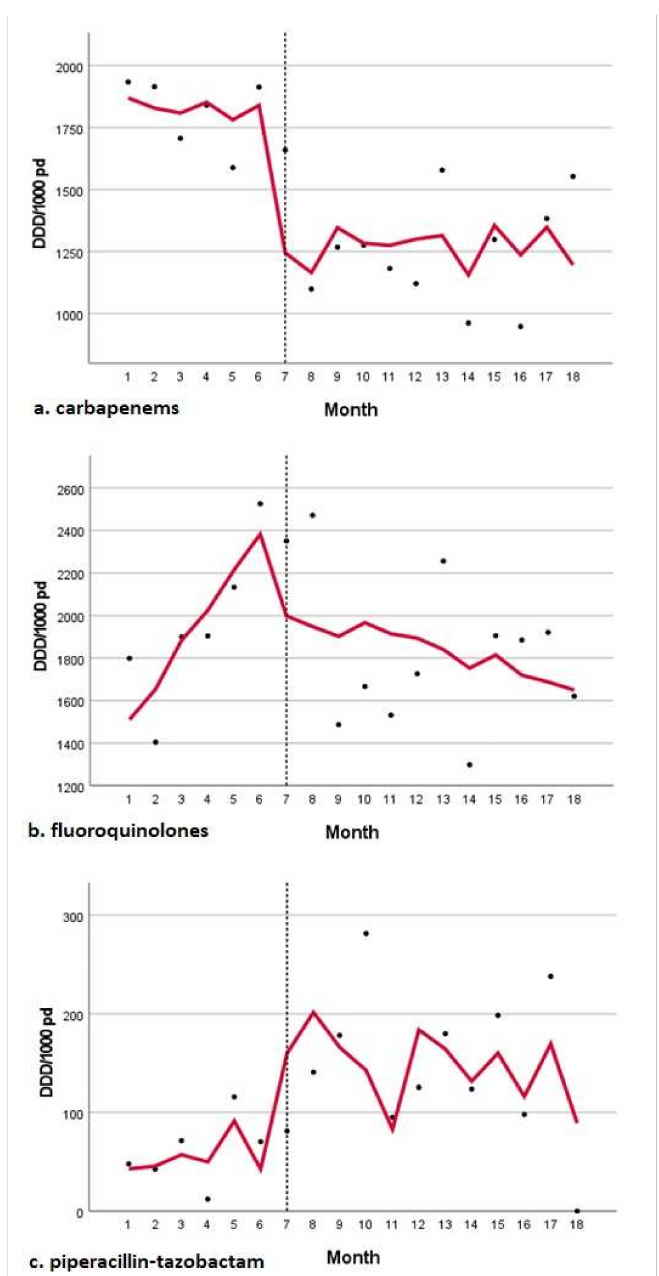
Figure 1. Time series analysis of antibiotic consumption. ( a ) carbapenem ( b ) fluoroquinolones ( c )